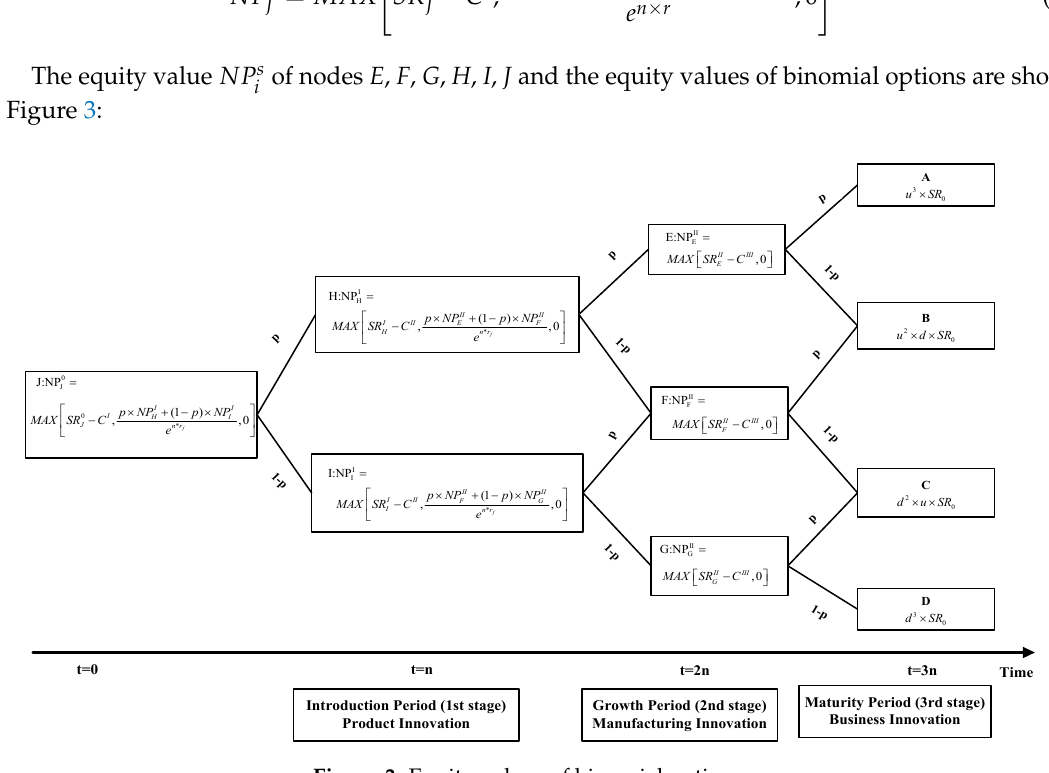
Figure 3. Equity values of binomial options.